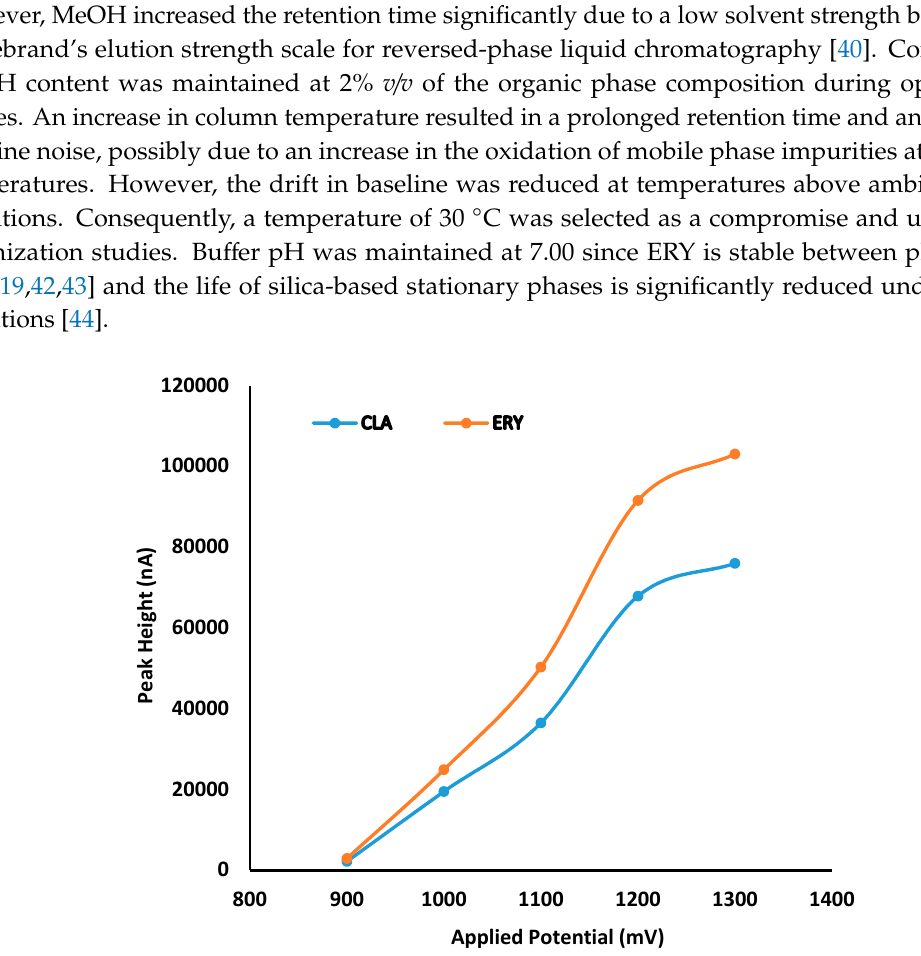
Table 1. Variables and experimental design values.